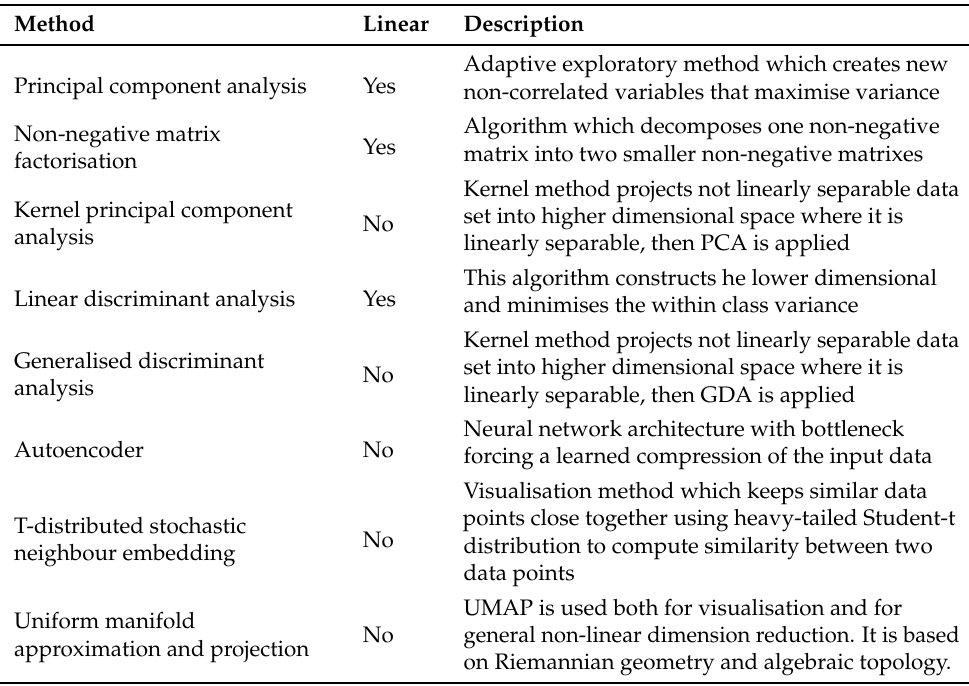
Table 1. Common data reduction methods.